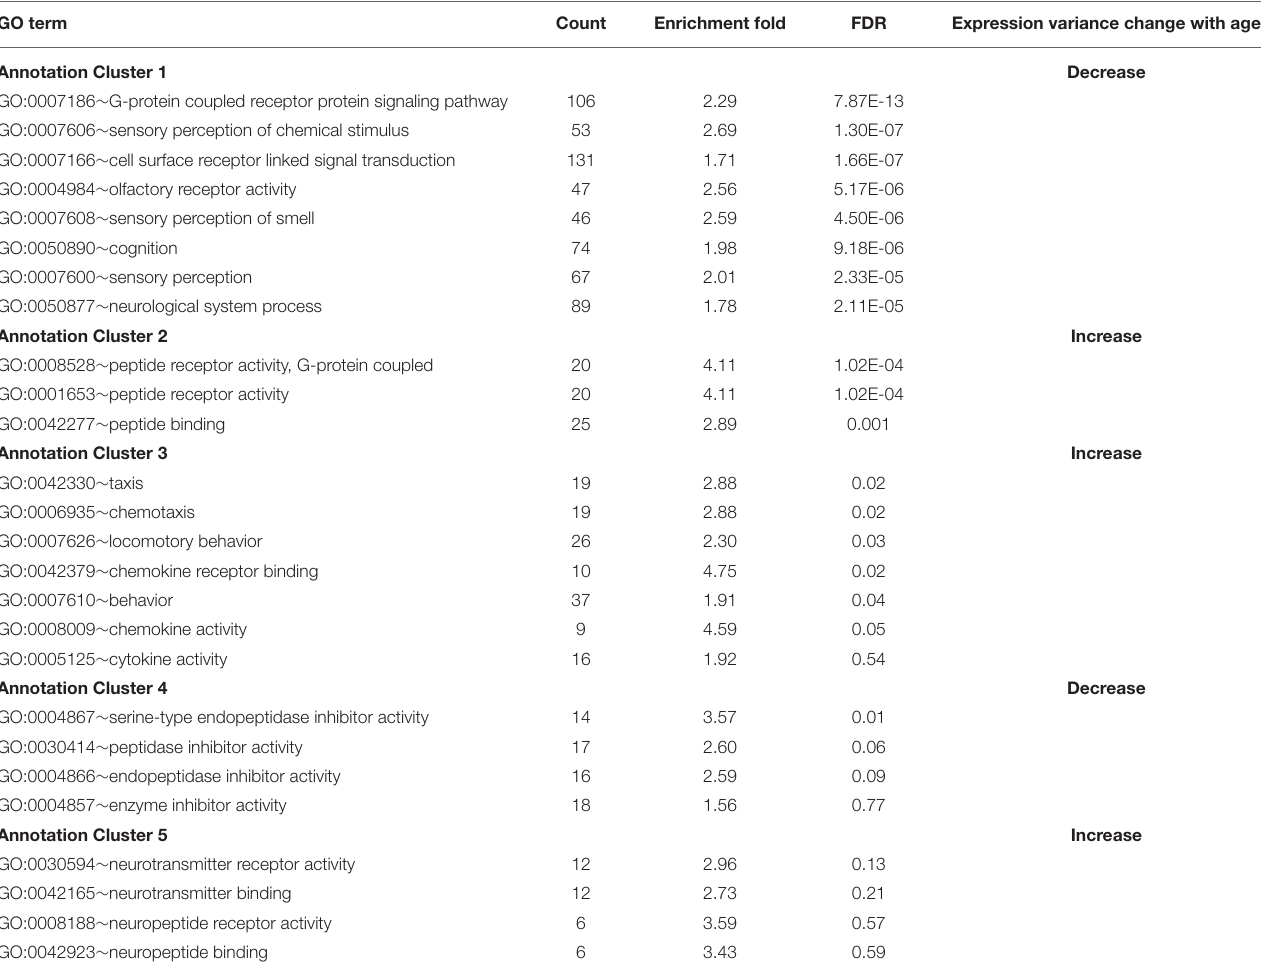
TABLE 2 | GO-term clusters for DV genes showing the most differential variability in expression between age groups. GO term Count Enrichment fold FDR Expression variance change with age Annotation Cluster 1